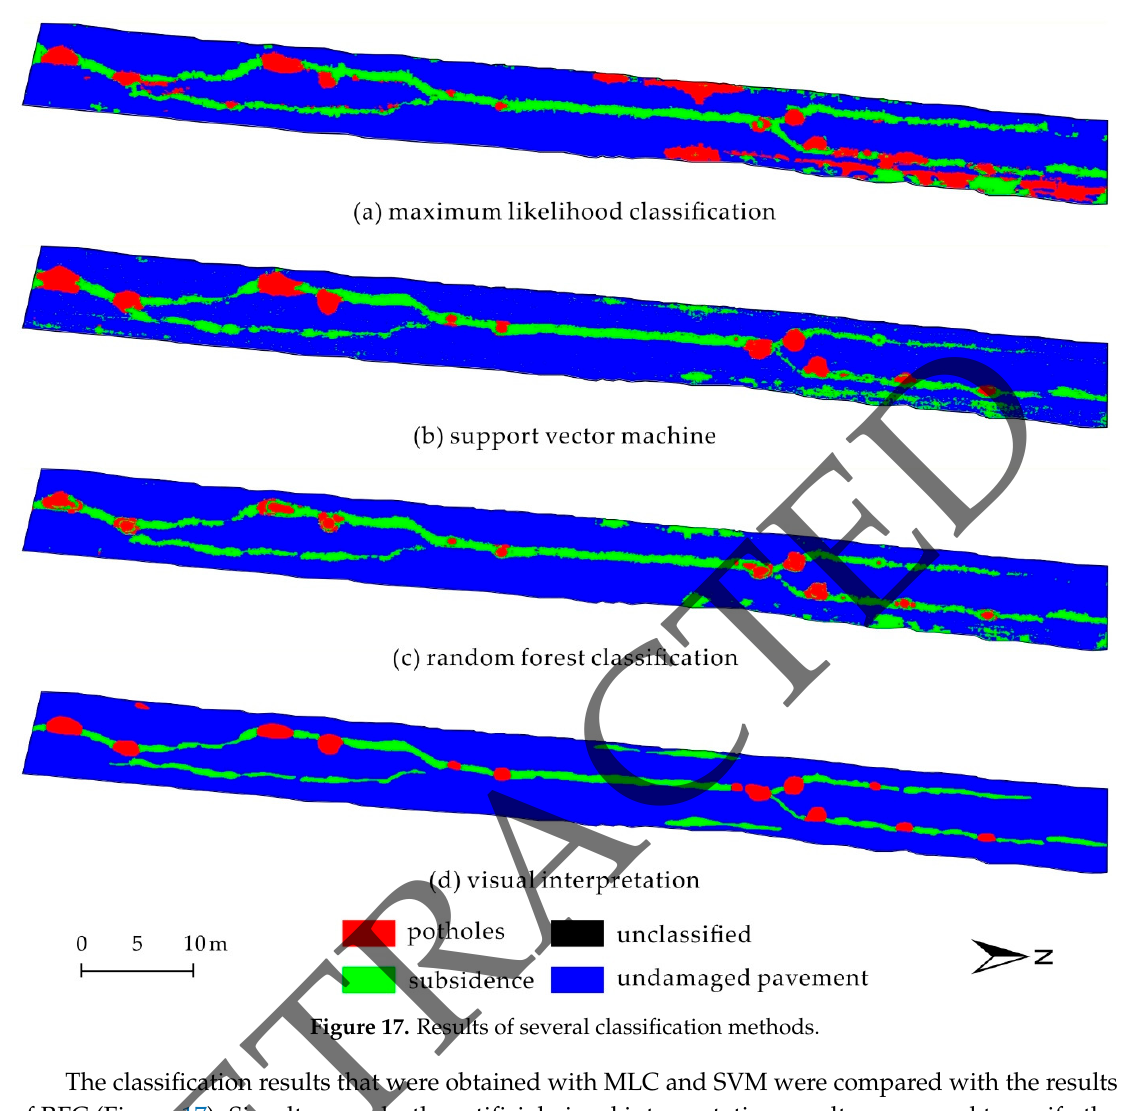
Figure 17. Results of several classification methods.